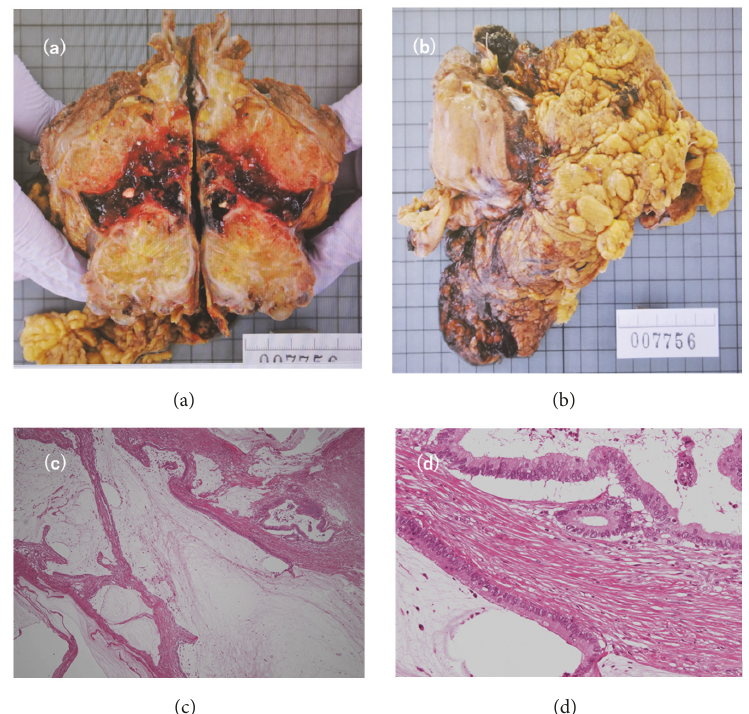
Figure 3: (a) and (b) show surgical specimen of the urachal carcinoma. The tumor was removed, along with surrounding adherent organs, including the omentum, peritoneum, and bladder dome. Disseminated nodules were detected in the omentum. (c) and (d) show cords of adenocarcinoma cells in abundant mucin (H&E stain).